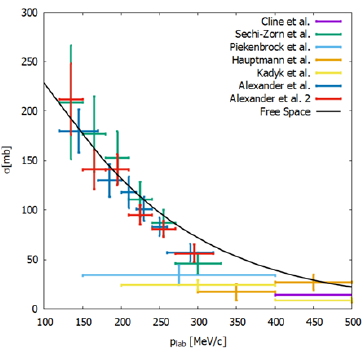
Figure 4. (Color online) Results of our SU(3) approach to BB octet interactions for the Λ p total cross section are compared to